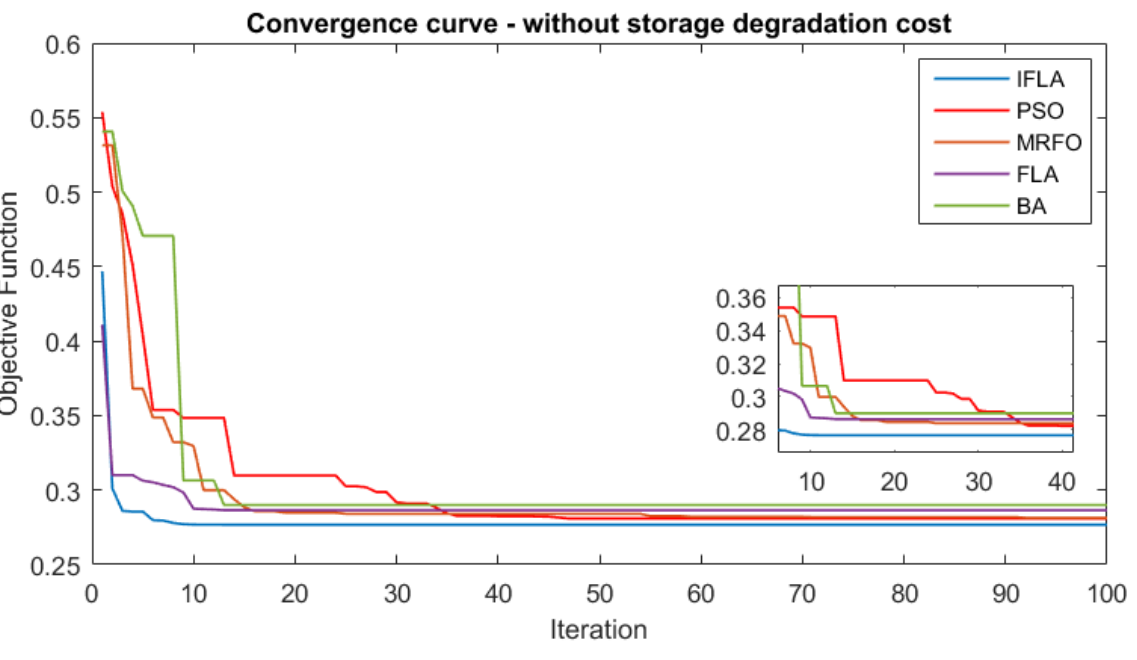
Figure 7. The convergence process of different algorithms to solve the WT/Battery scheduling problem without storage degradation